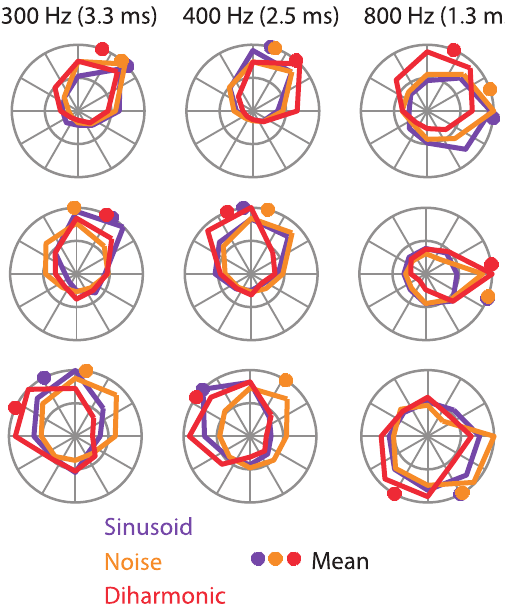
Figure 4. Phase tuning for complex stimuli. Normalized histo- grams showing phase tuning for sinusoidal (purple), diharmonic (red), and band-pass noise stimuli (orange) at three different frequencies (indicated at the top, along with the corresponding cycle duration) for three example neurons (rows). Colored dots indicate preferred phase. The phase tuning is highly consistent across stimulus types.